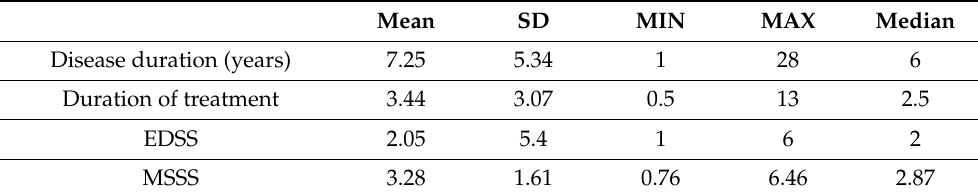
Table 1. Clinical characteristics of the group of MS patients under study ( n = 65); EDSS—Expanded Disability Status Scale, MSSS—Multiple Sclerosis Severity Scale.